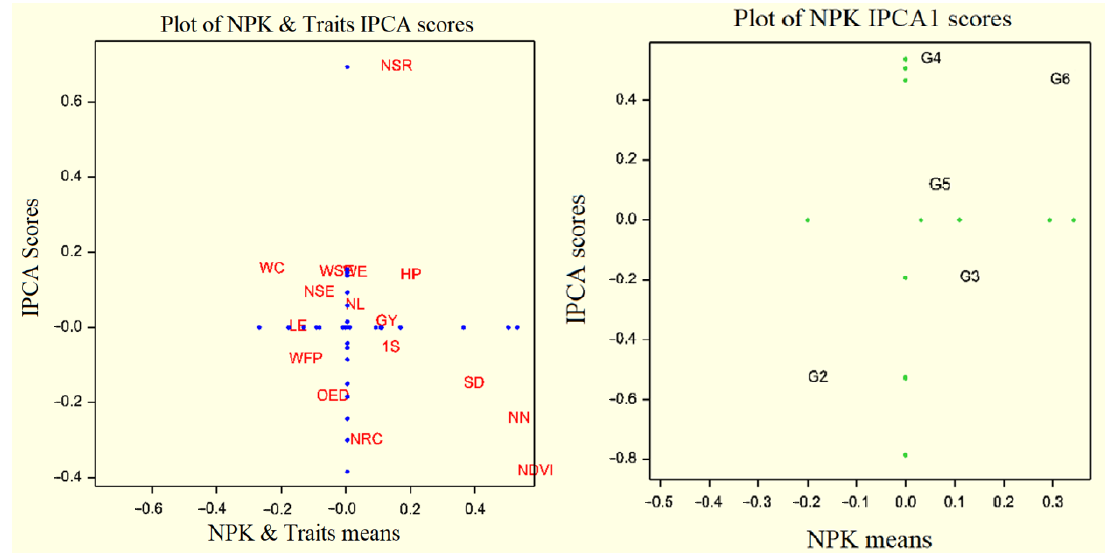
Figure 3. Biplot average traits and NPK of hybrid FAO340 on different treatment levels at principal component values (AMMI). Chlorophyll (Chl), NDVI (NDV), plant height (HP), leaf number (LN), stem diameter (SD), diameter of ear (OED), node number (NN), weight of ear (WE), weight of cob corn (WC), weight of ear (WE), weight of cob (WC), number of seeds in row (NSR), number of seeds per column (NSC), length of ear (LE), weight of all seeds in ear (WSE), number of seeds per ear (NSE), weight of fresh plant (WFP), weight of 1000 seeds (1S), grain yield (GY). G0untilG5 treatments NPK.